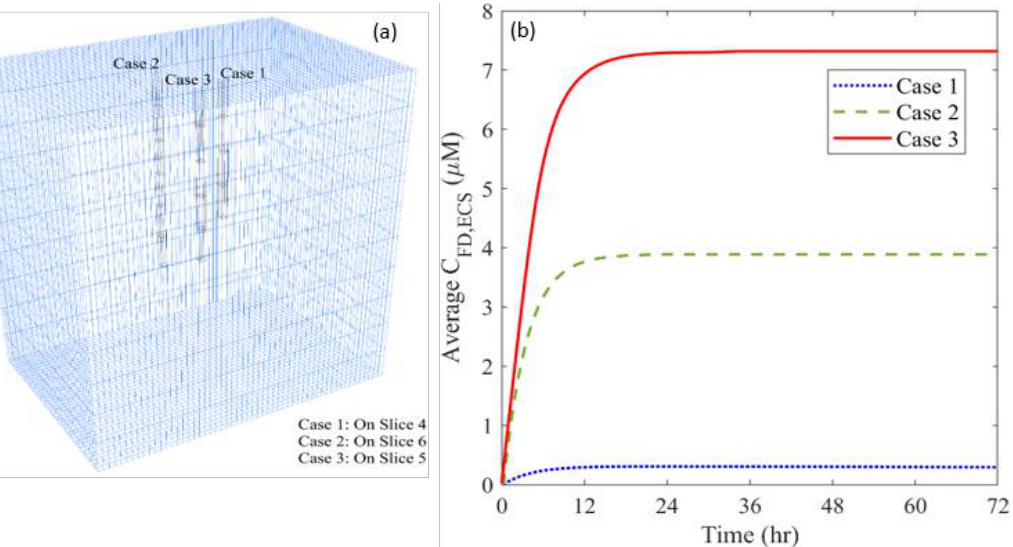
Figure A6. ( a ) Location of different infusion sites of plasma volume fraction, and ( b ) its impact on the time course of free temozolomide concentration in the brain tumor.